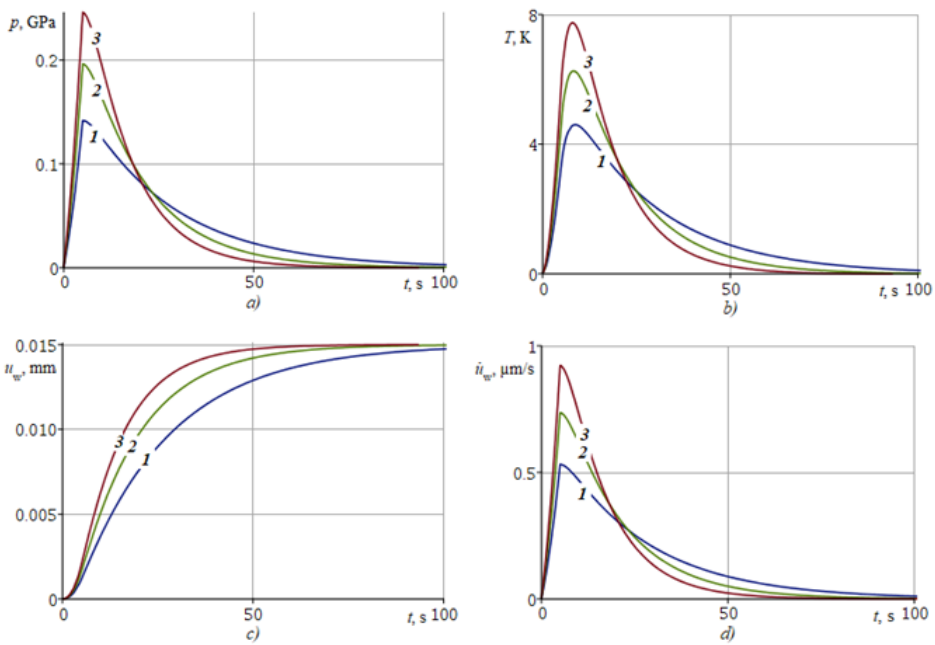
Figure 6. Dependence of the main contact characteristics by time: ( a ) contact pressure p ( t ) = − σ xx ( h , t ) , ( b ) contact temperature T ( h , t ) , ( c ) coating wear u w ( t ) , ( d ) coating wear rate for different values of shear modulus in the middle of the coating µ 1/2 : 1 —50, 2 —75, 3 —100 GPa. Figure 6 shows that the coating wear is accompanied by an increase in contact stress p ( t ) and temperature T ( h , t ) . The growth of the contact stress p ( t ) is explained by the proportionality of the stresses σ xx ( x , t ) to the shear modulus µ ( x ) according to (3). The temperature T ( h , t ) is proportional to the contact stresses σ xx ( x , t ) , according to (9), and, hence, to the shear modulus µ ( x ) . Since curve 3 indicates a greater stiffness of FGM than curve 1 (Figure 5), the values of p ( t ) and T ( h , t ) for curve 3 will exceed the values of these characteristics for curve 1 (Figure 6). The wear of the coating demonstrating higher stiffness (curve 3 ) will occur faster than the wear of the less stiff coating (curve 1 ), for the same reason according to (8), and also because the vertical movement of abrasive I carried out forcibly according to the law for ∆ ( t ) . Hence, it follows that it is possible to experimentally determine the depth-variable shear modulus of the FGM coating under wear conditions in accordance with the kinematic law for ∆ ( t ) of abrasive I, using pressure and temperature sensors at the